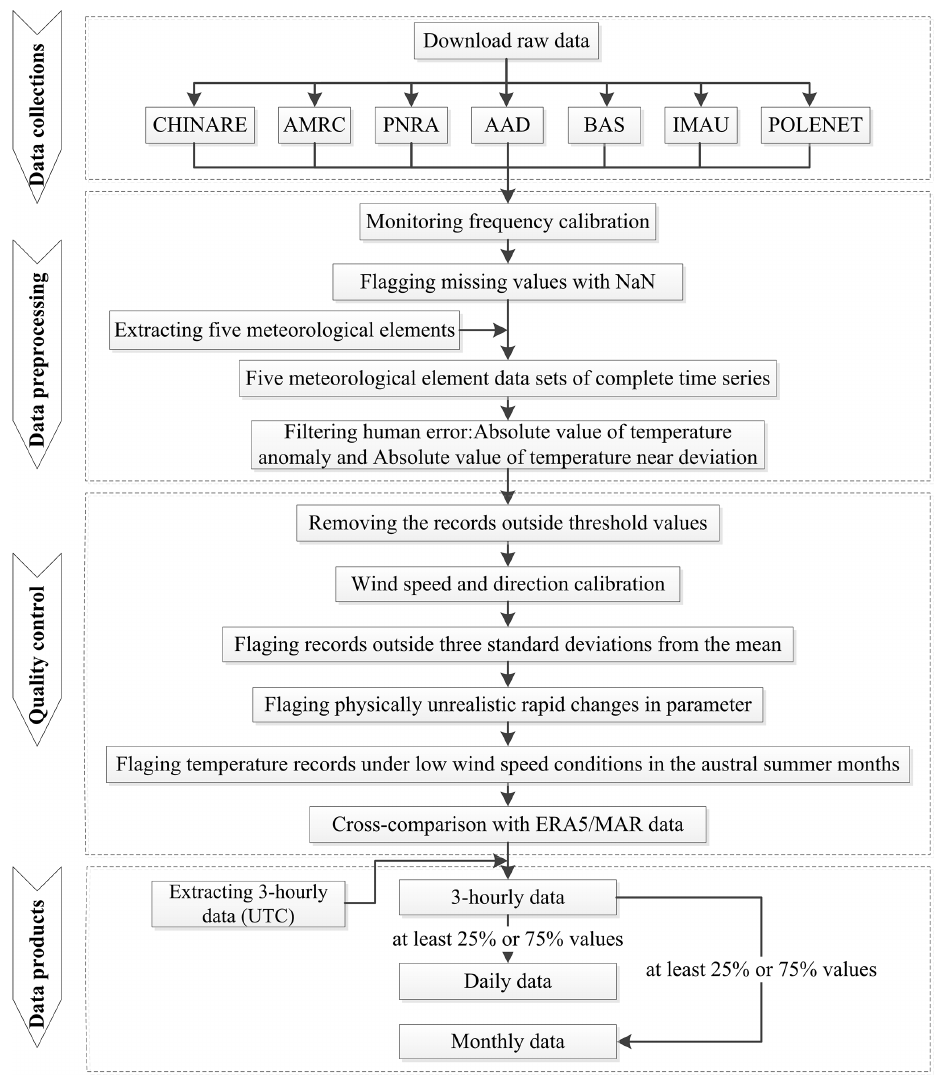
Figure 4. Description of the AWS data processing